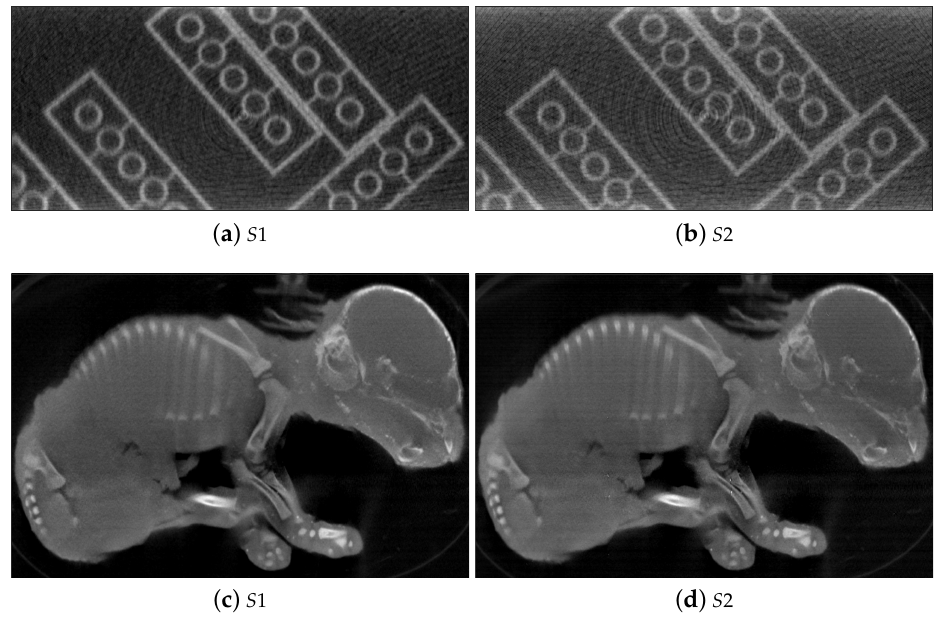
Figure 6. Reconstructions of the test phantom ( a , b ) and the piglet ( c , d ) datasets acquired by the 3D 2 YMOX system with calibrated geometry. With geometry correction, the LEGO bricks and the piglet structure are clearly visible in the CT